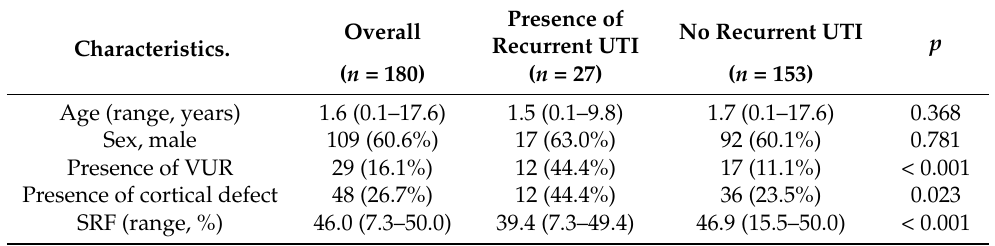
Table 1. Clinical characteristics of patients.